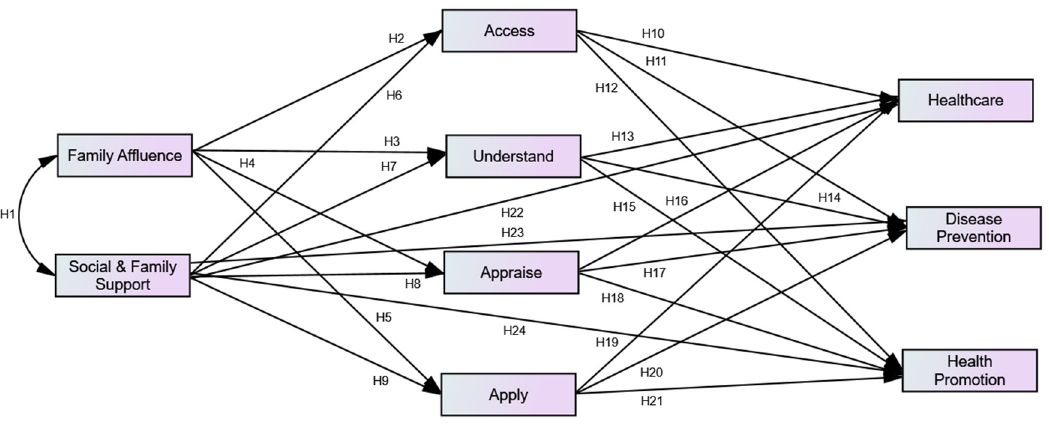
Figure 2. Conceptualization of hypotheses development. See Appendix A for H 1 –H 24 descriptions .